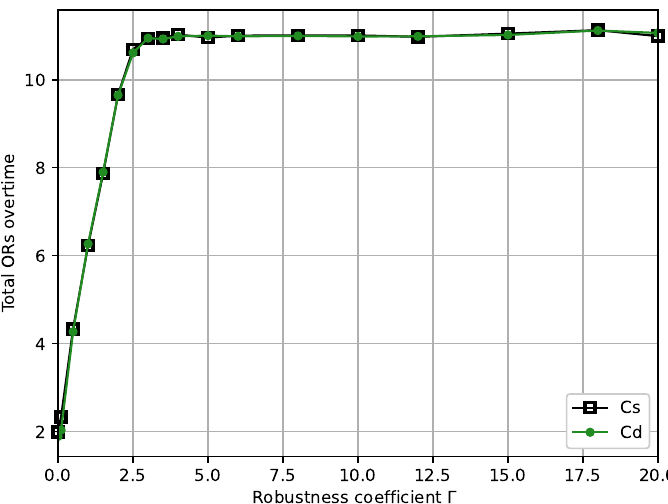
Figure 5. Total ORs overtime versus robustness coefficient Γ .